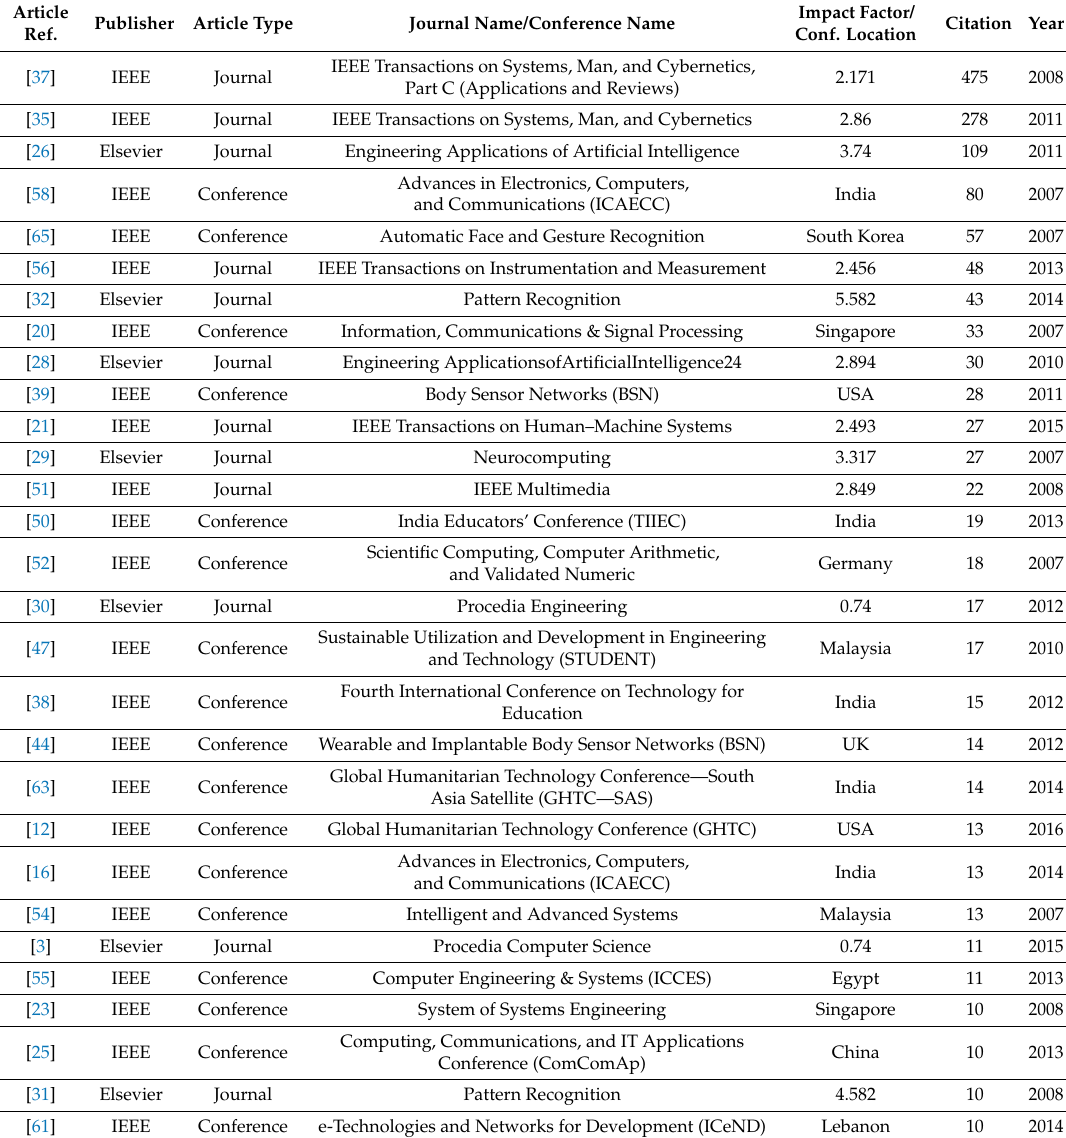
Table 2. The metric information of the articles in the previous